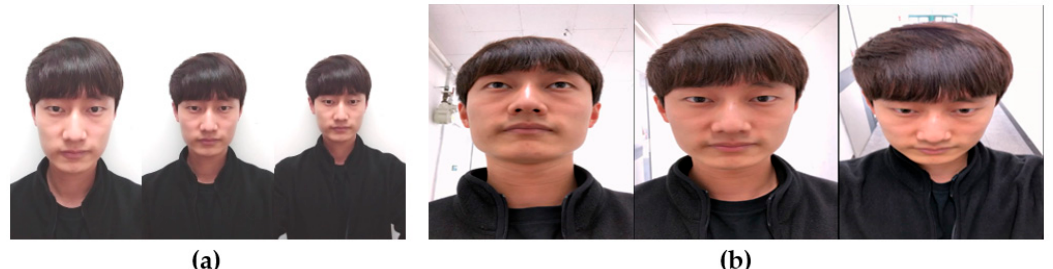
Figure 3. Samples from the real face database: ( a ) three distances (near, halfway, distant); ( b ) three angles (bottom, middle, top).